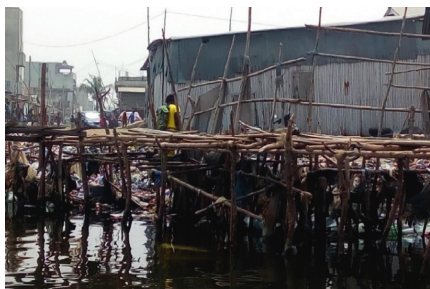
Figure 1: Human settlement on the Lake Nokou´e bank at Y´enawa- Cotonou (southeast of Lake Nokou´e).